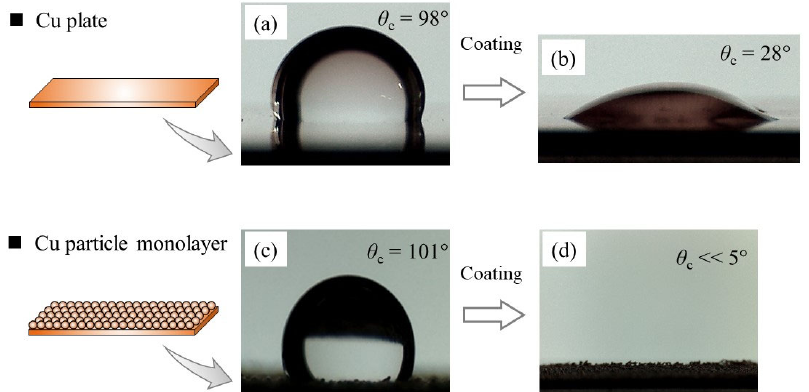
Figure 5. Contact angle measurement using a water droplet: ( a ) Cu flat plate, ( b ) coated Cu flat plate, ( c ) Cu particle monolayer, and ( d ) coated Cu particle monolayer.